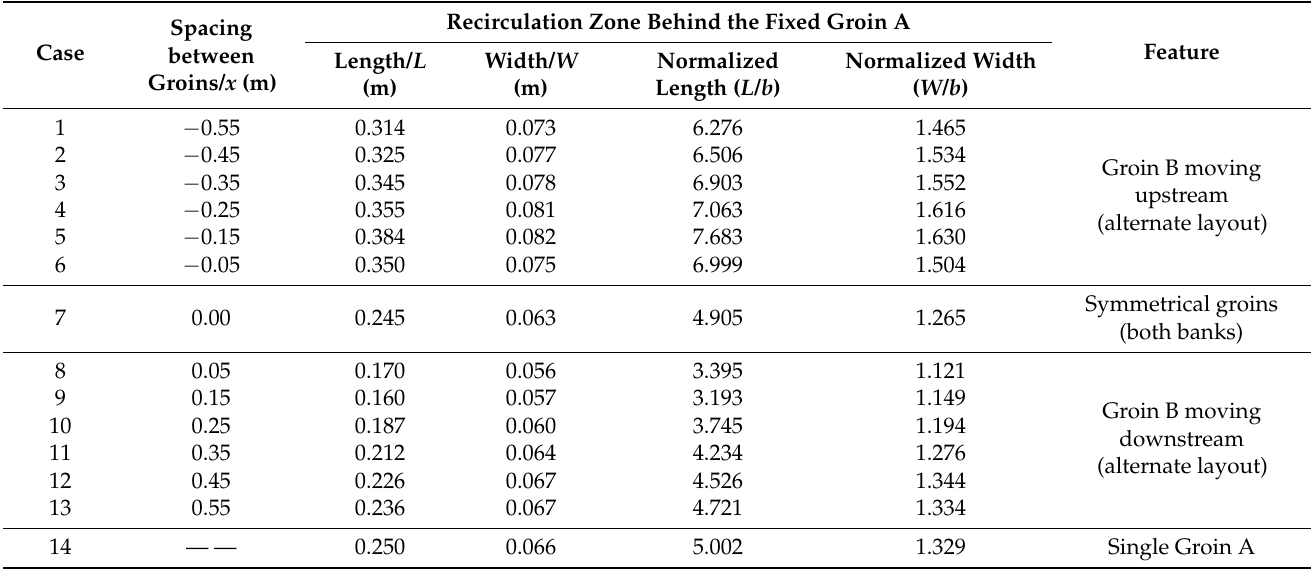
Table 1. Experimental results of the horizontal recirculation zone behind Groin A for different cases.